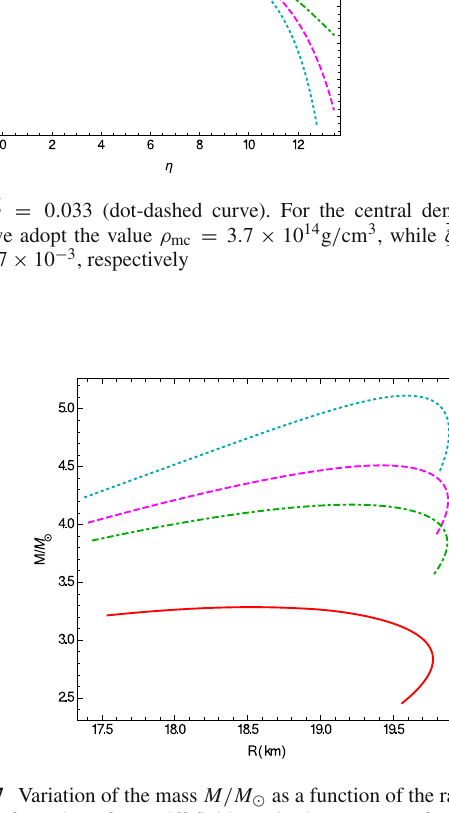
Fig. 4 Variations of ¯ ρ m (left panel), and of ¯ m (right panel) as a func- tion of η for three-form stiff-fluid stars in the presence of a Higgs-type potential, for ¯ a = 0 . 003 and for three different values of the constant ¯ b : ¯ b = 0 (dashed curve), ¯ b = − 0 . 033 (dotted curve), and ¯ b = 0 . 033